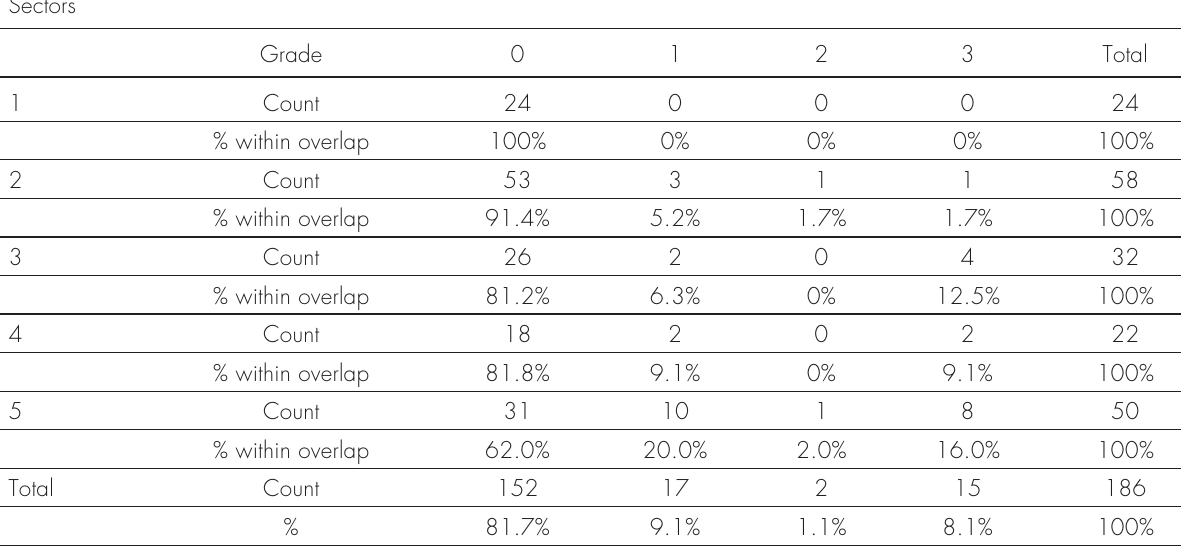
Table I. Overlap of canine, by sectors correlated to severity of resorption by grade.